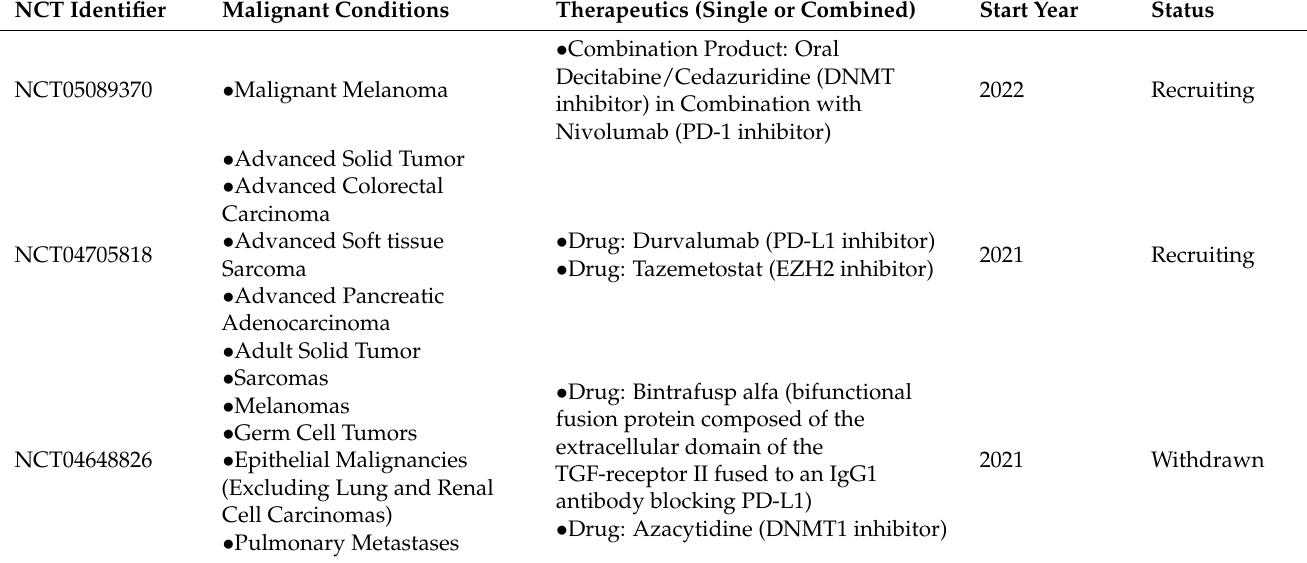
Table 1. Clinical trials of epigenetic agents combined with immune checkpoint inhibitors for cancer